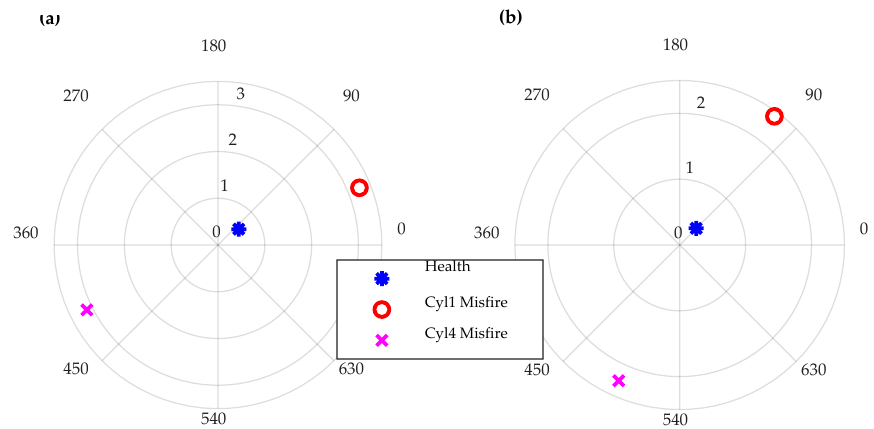
Figure 18. Polar plotting of the fault indicators at 1200 rpm and: ( a ) 0 Nm; ( b ) 105 Nm.